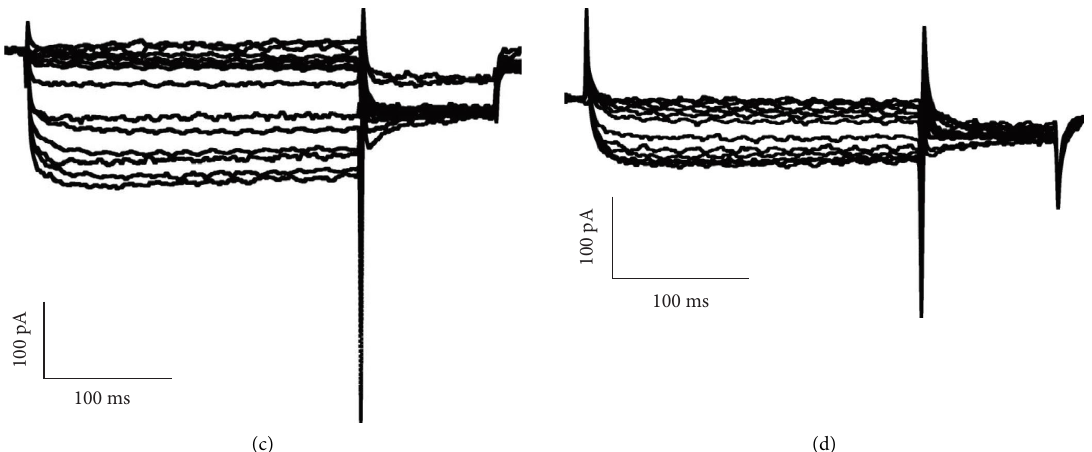
Figure 5: Te hCaV1.2 currents were detected before and after 30mg/L SXB perfusion in tsA-201 cells. (a) Voltage protocol was listed in detail in results 3.4. (b) Peak currents were compared between 30mg/L SXB ( n � 14) and control ( n � 24). ∗∗ P < 0 . 01, vs. the CON group. hCaV1.2 channel currents were detected before (c) and after (d) 30mg/L SXB perfusion.